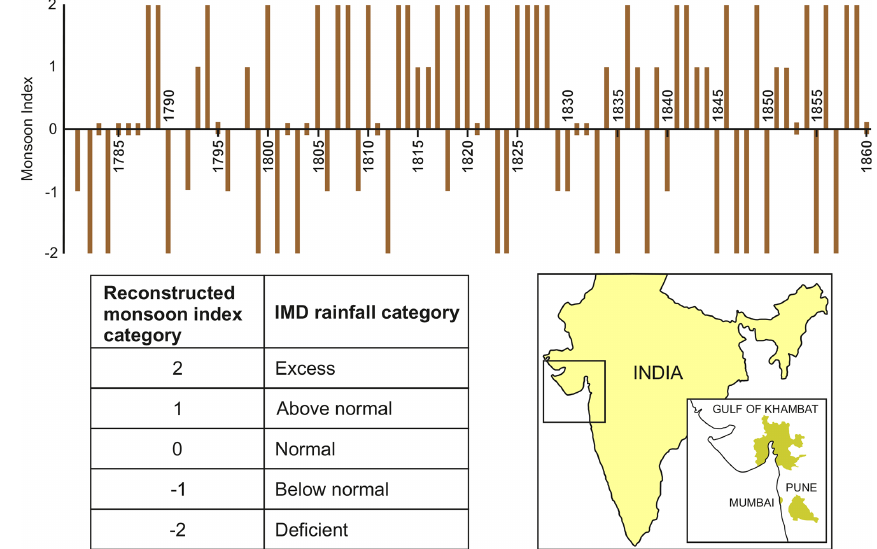
Figure 4. Five-point western India monsoon rainfall reconstruction for 1780–1860. The reconstruction is a combination of separate series for Mumbai, Pune, and the Gulf of Khambat (now the Gulf of Khambhat; see inset). Monsoon index categories map broadly onto Indian Meteorological Department (IMD) descriptors of seasonal monsoon rainfall (data for reconstruction from Adamson and Nash, 2014). Zero values are shown as small bars; years with insufficient data to generate an index value are left